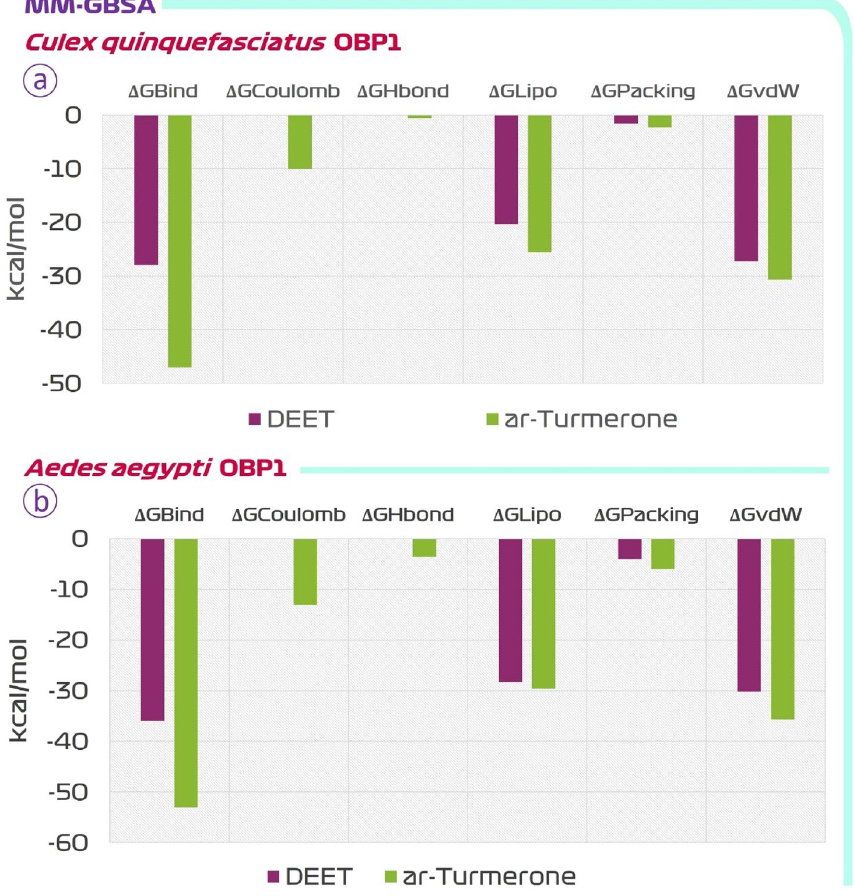
Figure 8. MM-GBSA assessment of DEET and ar-turmerone for their interaction propensity with OBP1 of ( a ) C. quinquefasciatus, and ( b ) A. aegypti , ΔGBind binding energy, ΔGCoulomb Coulomb energy, ΔGHbond hydrogen-bonding correction, ΔGLipo lipophilic energy, ΔGPacking Pi-Pi packing correction, ΔGvdW Van der Waals